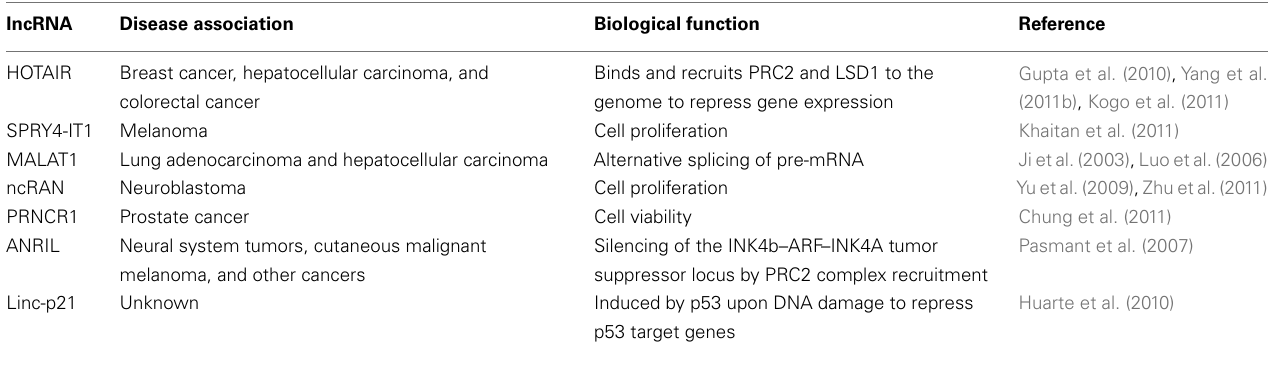
Table 1 | Examples of IncRNAs that are dysregulated in cancer. IncRNA Disease association